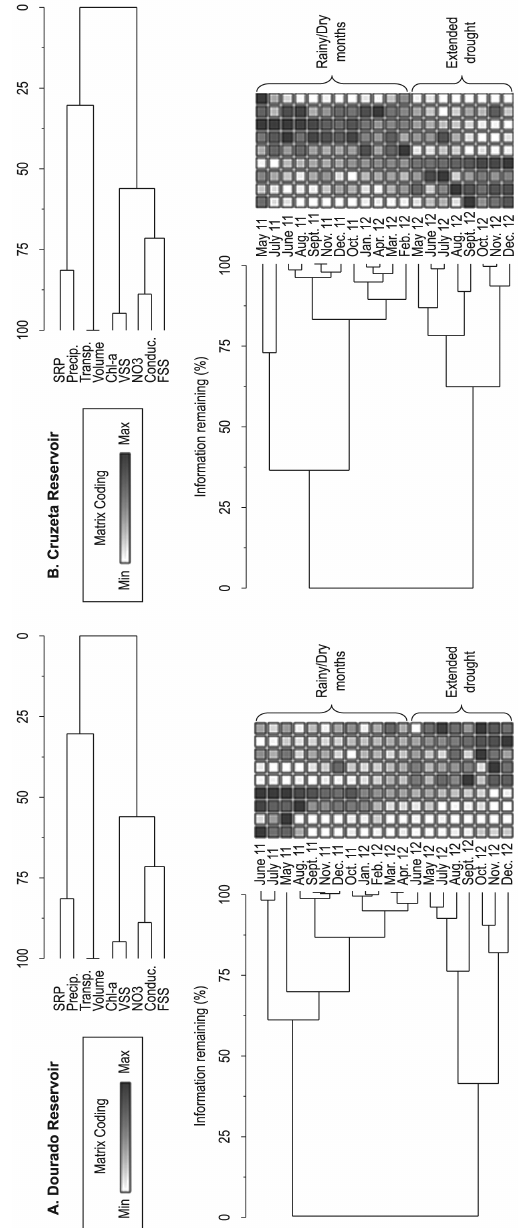
Figure 5. Two-way Cluster Analysis of Dourado (A) and Cruzeta Reservoir (B). Samples are clustered in lines while environmental variables are clustered in columns. Dark squares express maximum values of each variable while white ones represent minimum